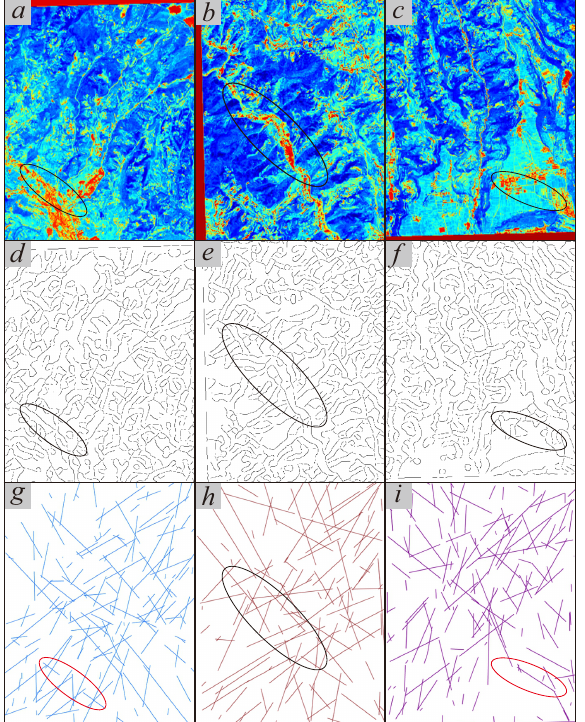
Figure 4. The lineaments extraction example: the first row is the Gaussian high-pass results, the second row is the edge detection by tensor voting, and the third row is the lineaments after Hough transform Gaussian high-pass filter allowed the region where the gray fre- quency changes fast to passes through, but suppresses the op- posite region. This feature is characterized by rapid gray scale changes and high gradients, which made edge points more